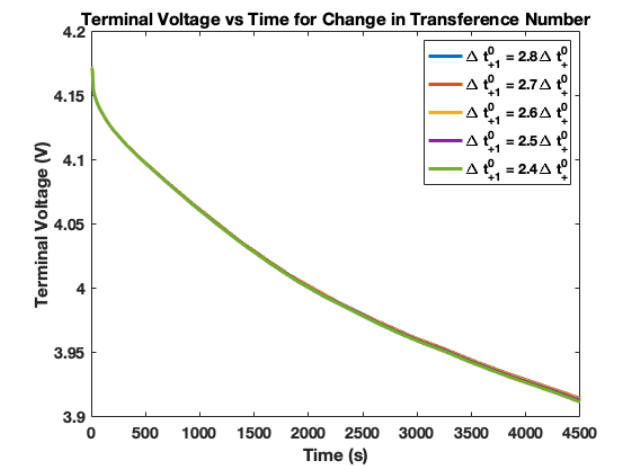
Figure 7. Terminal voltage vs. time for change in transference number from 2.8 to